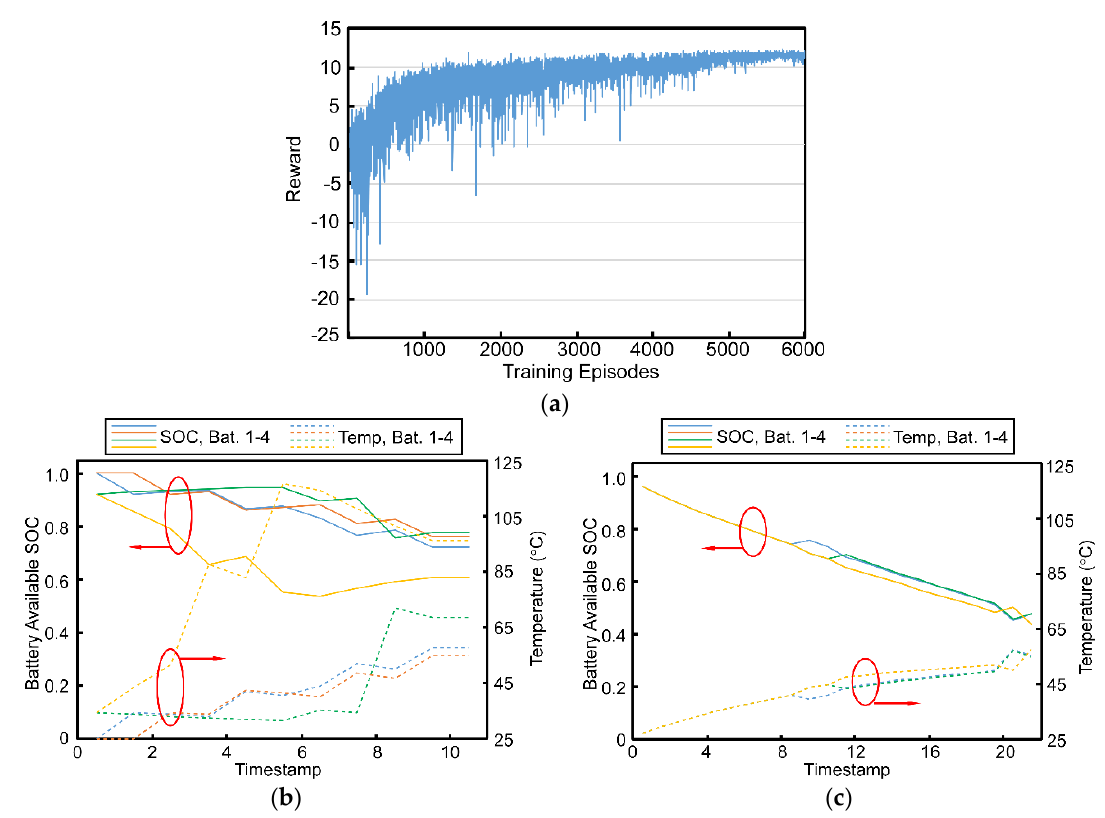
Figure 8. ( a ) Total reward during training, with temperature effect enabled. ( b ) SOC and temperature curves before training. ( c ) SOC and temperature curves after training. The agents tended to discharge evenly to reduce the current, thus reducing the generated heat.